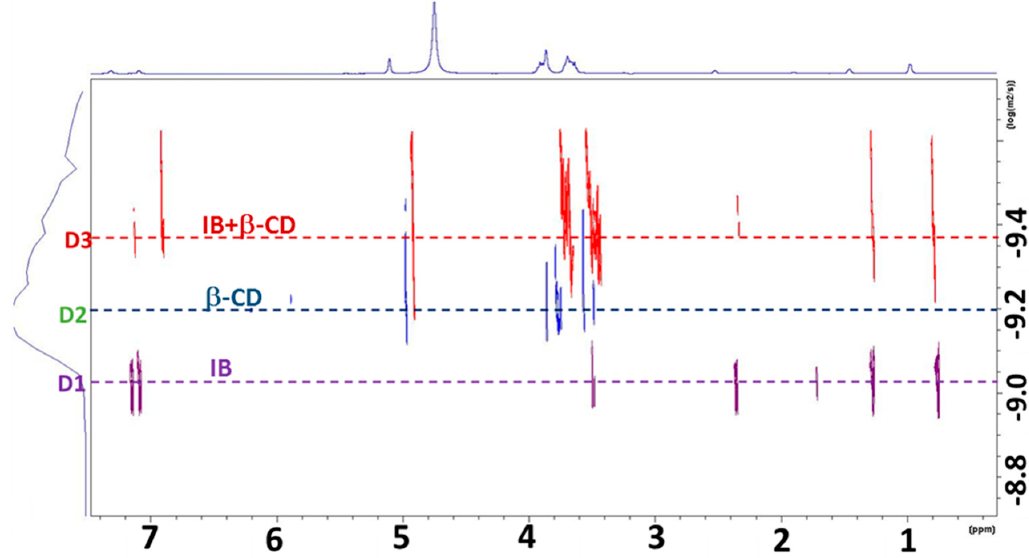
C1 hydrogel (purple), β -CD loaded in C1 hydrogel (blue) and IB / β -CD (1:1) complex loaded in Figure 6. Overlap of diffusion-ordered correlation spectroscopy (DOSY) maps of: IB loaded in C1 C1 hydrogel hydrogel (purple), β -CD loaded in C1 hydrogel (blue) and IB/ β -CD (1:1) complex loaded in C1 hydrogel (red).